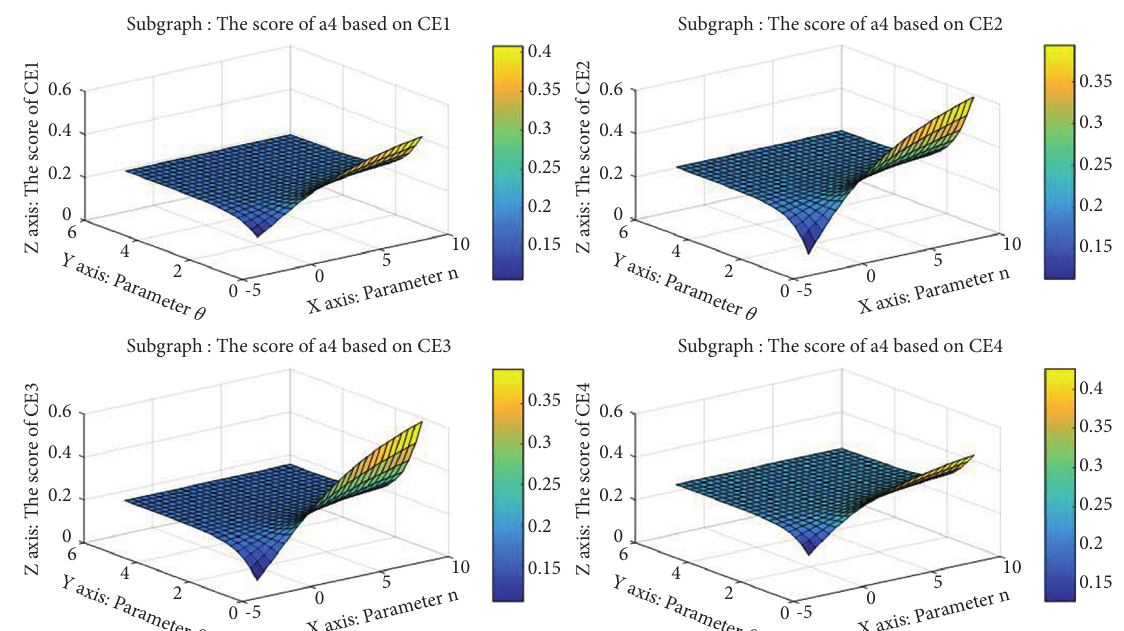
Figure 5: Score of alternative a